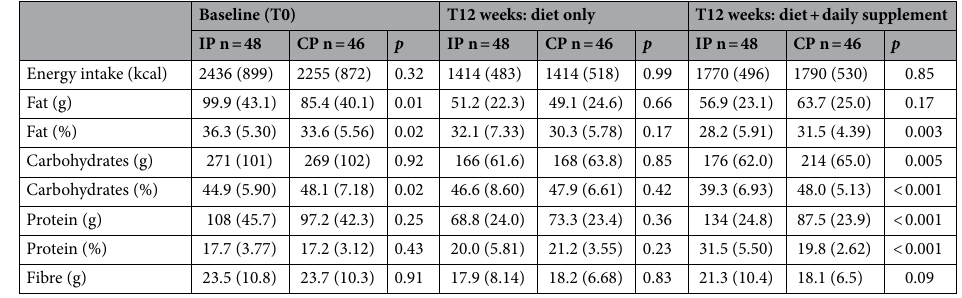
Table 2. Description of the nutritional intake before and after the intervention. Data is expressed as mean (SD) for continuous variables. Macro-nutrient intake is expressed as g/day or percent of total energy intake when specified. P values of Student t